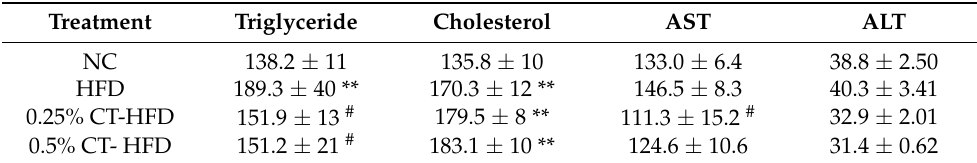
Table 1. Change of blood chemistry in C57BL/6J mice for 7 weeks of HFD-fed group and HFD-fed treated with